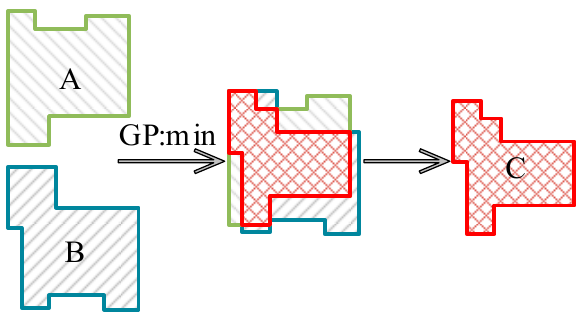
Figure 3. Graphical interpretation of the Intuitionistic Fuzzy Set-Interpolation Boolean Algebra (IFS-IBA) operation on polygons. Legend: GP, generalized product.